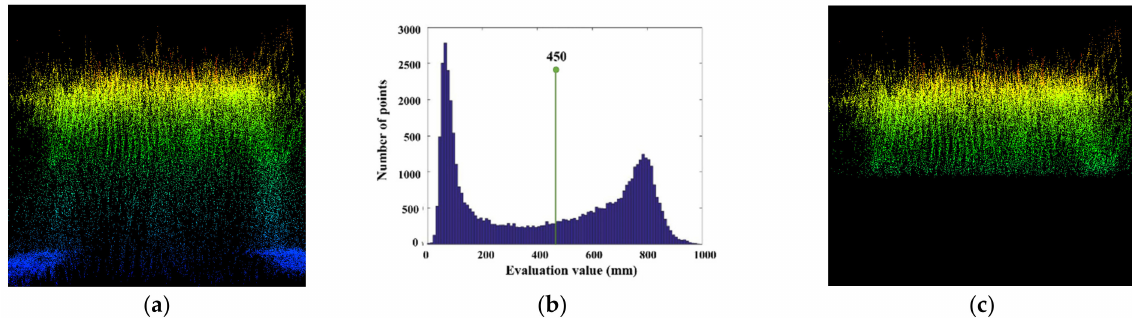
Figure 5. Point-cloud data segmentation by elevation threshold: ( a ) elevation value of point-cloud data, ( b ) histogram of elevation distribution and ( c ) segmentation based on elevation threshold.